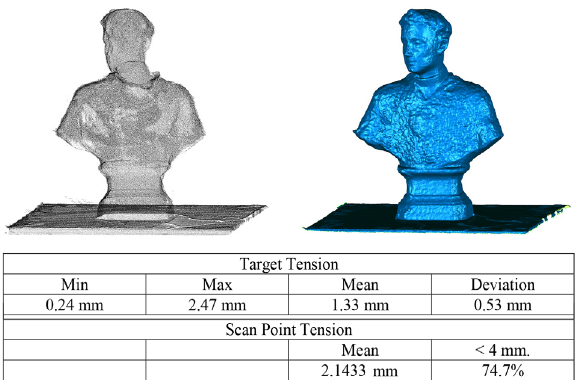
Figure 4. 3D model (laser scanner and